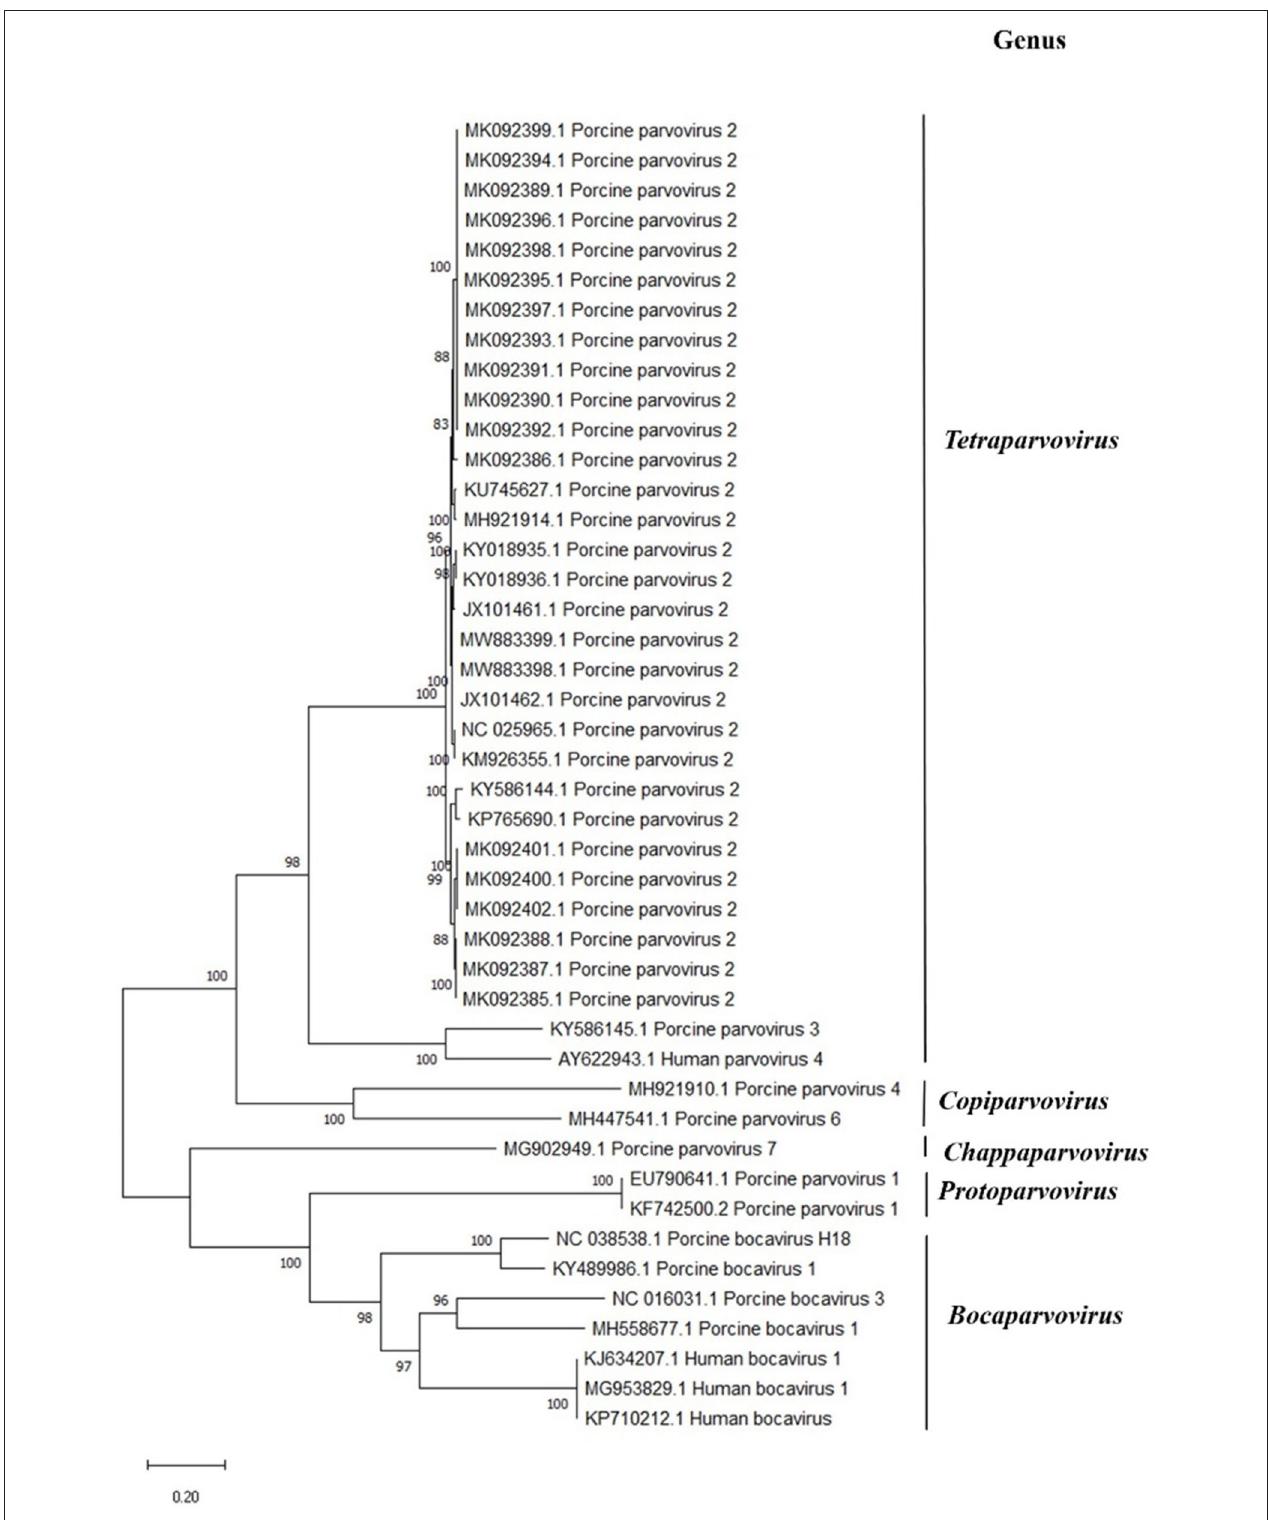
FIGURE 3 | Phylogenetic analysis of members of the Parvovirinae subfamily in comparison to porcine parvovirus 2 (PPV2). The analysis involved 44 nucleotide sequences of vertebrate parvovirus with their GenBank accession numbers marked in the tree . The percentage of trees in which the associated taxa clustered together is shown next to the branches . Evolutionary history was inferred by using the maximum likelihood method and the Kimura two-parameter model. There were a total of 6,165 positions in the final dataset. Evolutionary analyses were conducted in MEGA X.